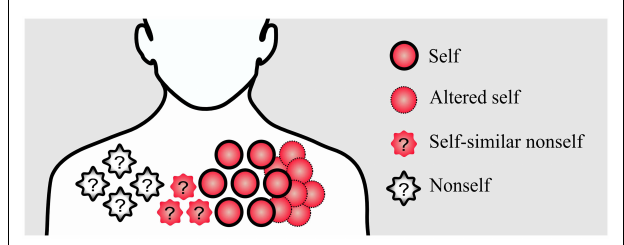
FIGURE 1 | Conceptual figure of different disturbances in the immune system . Pathogenic nonself-disturbances are recognized and attenuated by nonself-specific T cells. However, recognition and attenuation of altered self and self-similar nonself-disturbances is challenging for the immune system due to the existence of self-tolerance mechanisms; without self-specific immune cells, the immune system is not able to initiate an immune response against these